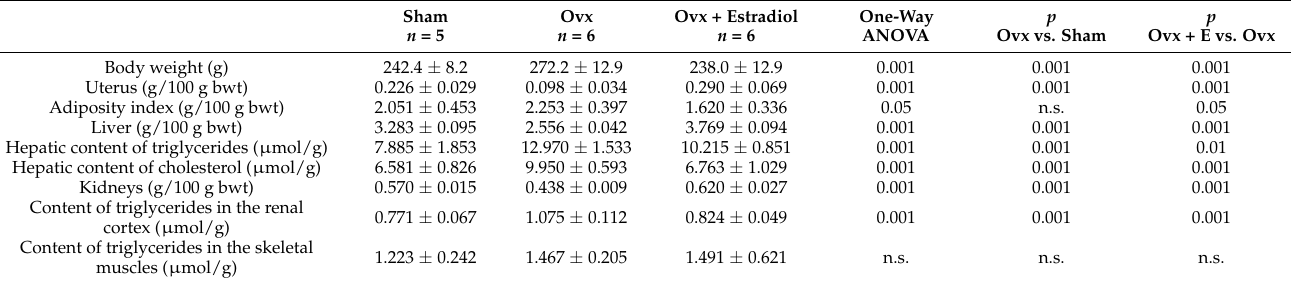
Table 1. Differences after Ovariectomy and Estradiol Substitution in Hereditary Hypertriglycer- idemic Rats in the Relative Weight and Lipid Content of Extracardiac Tissues and Organs. Ovx One-Way p p Sham Ovx +Estradiol ANOVA Ovx vs. Sham Ovx + E vs. Ovx n = 5 n = 6 n = 6